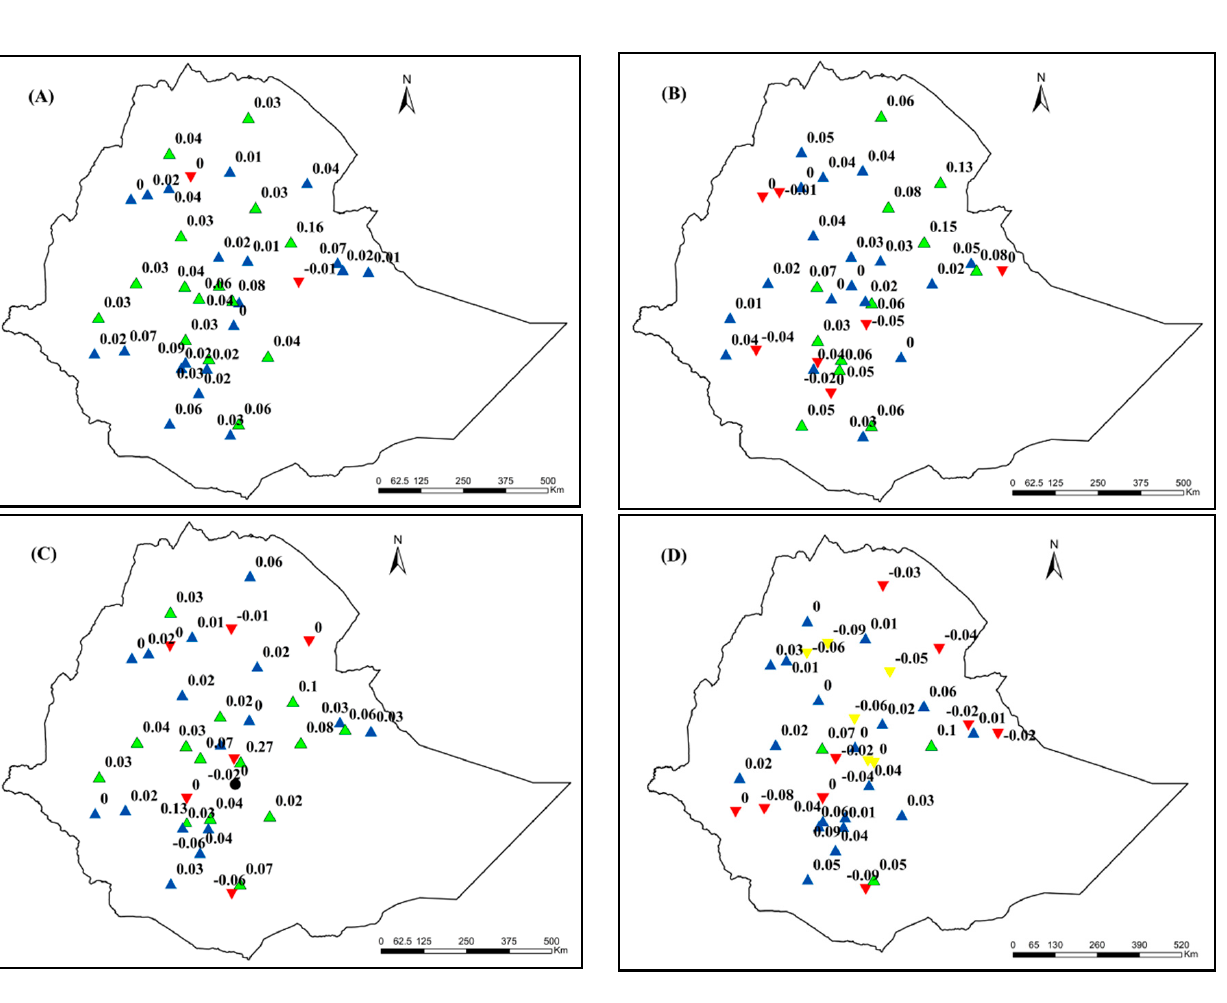
Figure 7. Spatial distributions of trends of the extreme temperature indices over Ethiopia for the long-term period between 1986 and 2020: ( A ) TXx, ( B ) TXn, ( C ) TNx, and ( D ) TNn. Note: Filled blue upright and filled red inverted triangles indicate increasing and decreasing trends, respectively, while circles filled in black indicate no trend. Significantly increasing and decreasing trends are symbolized by filled green upright triangles and filled yellow inverted triangles, respectively. Insignificant trends are represented by filled upright and inverted triangles.